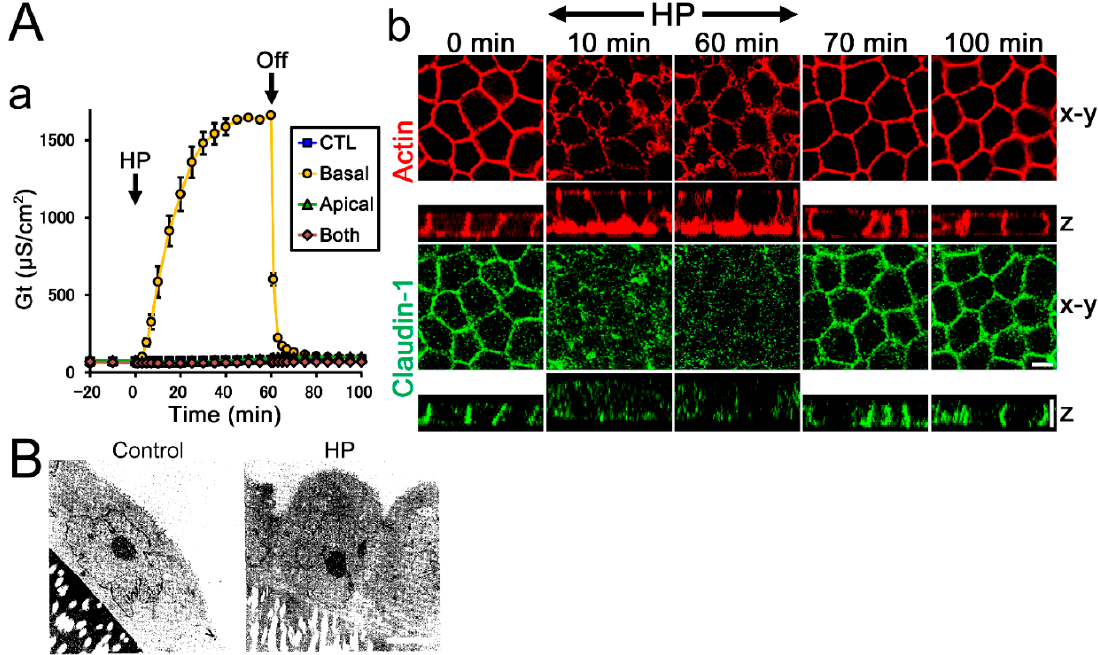
Figure 2. Effects of the hydrostatic pressure (HP) gradient in renal distal tubule cells and podocytes. ( A ) Effects of HP on Xenopus A6 cells. ( a ) Time course of transepithelial conductance. 8 cmH 2 O HP was applied from apical, basal, or both sides from time 0 to 60 min. The HP from basal side increased transepithelial conductance with reversibility. ( b ) Immunofluorescence of F-actin and claudin-1. 8 cmH 2 O HP from basal side was applied from time 0 to 60 min. HP from basal side increased cell height and altered actin structure and claudin-1 localization with reversibility. Modified from Tokuda et al., Biochem. Biophys. Res. Commun. 2009 [51] with permission. ( B ) Transmission electron micrographs of podocytes. 1 cmH 2 O HP was applied from basal side for three days. Podocyte cells showed more round shape and had wide intercellular space when the HP was applied from basal